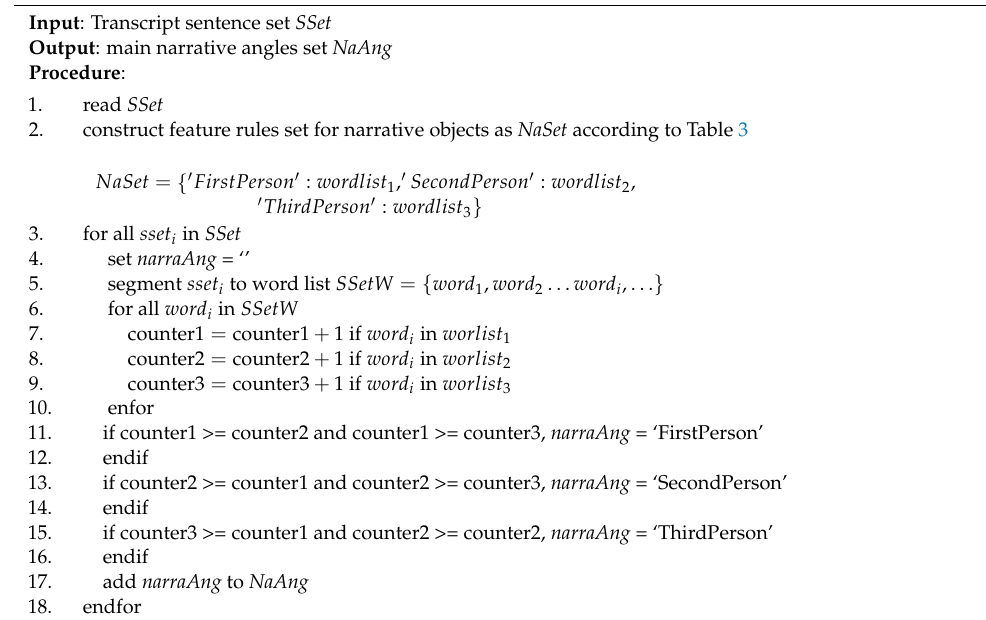
Algorithm 6. Main narrative angle analysis.